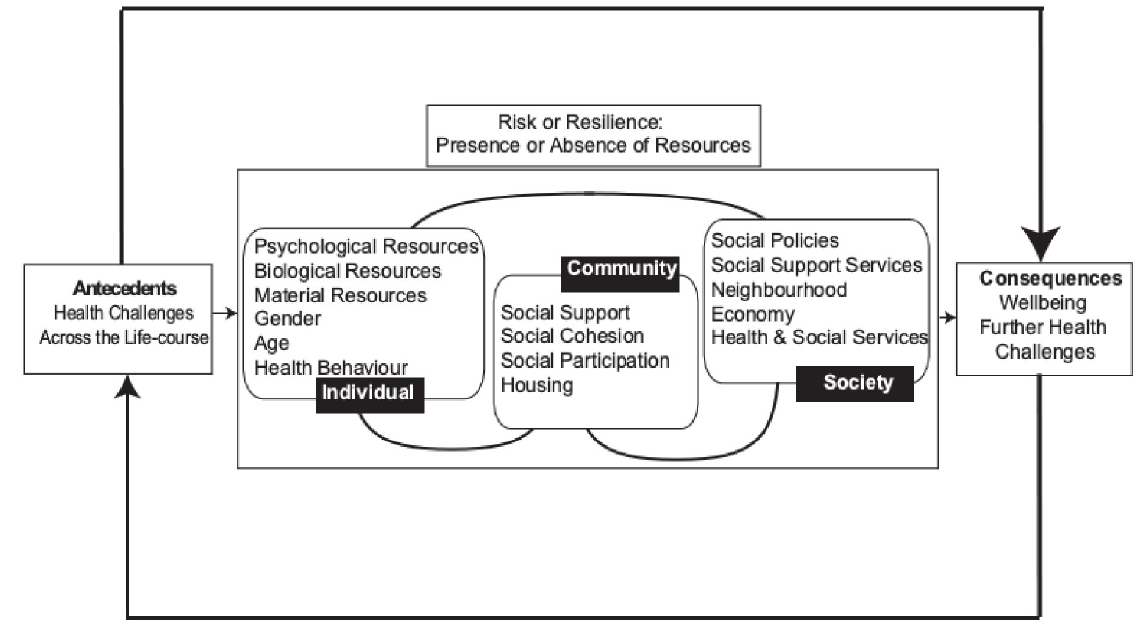
Fig 2. Ecological model of resilience